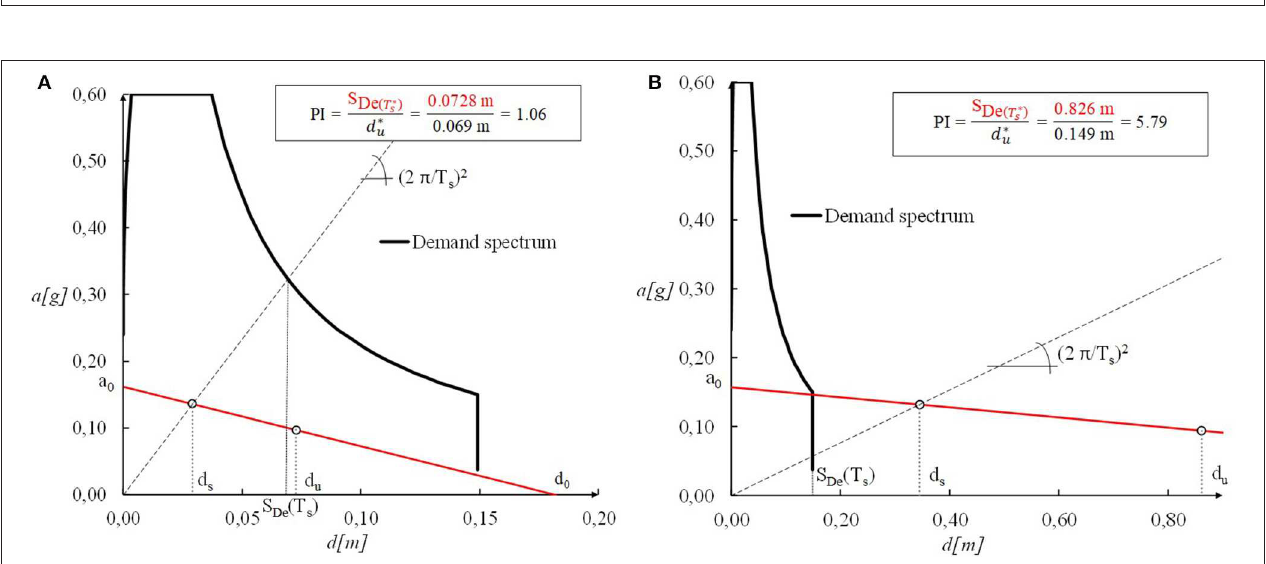
FIGURE 13 | Seismic vulnerability from non-linear kinematic analyses. (A) Verification in the longitudinal direction (X) of the 3D model. (B) Verification in the transversal direction (Y) of the 3D model.